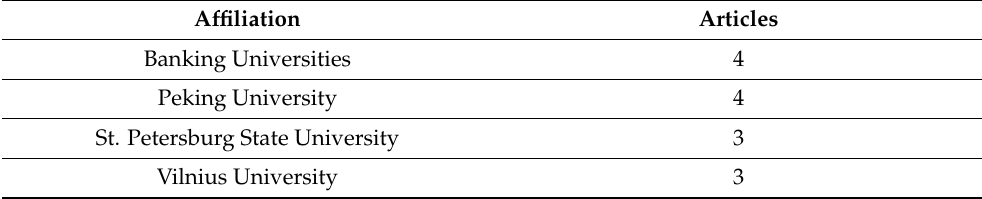
Table 3. Top universities engaged in the field of risks in fintech (‘Authors’